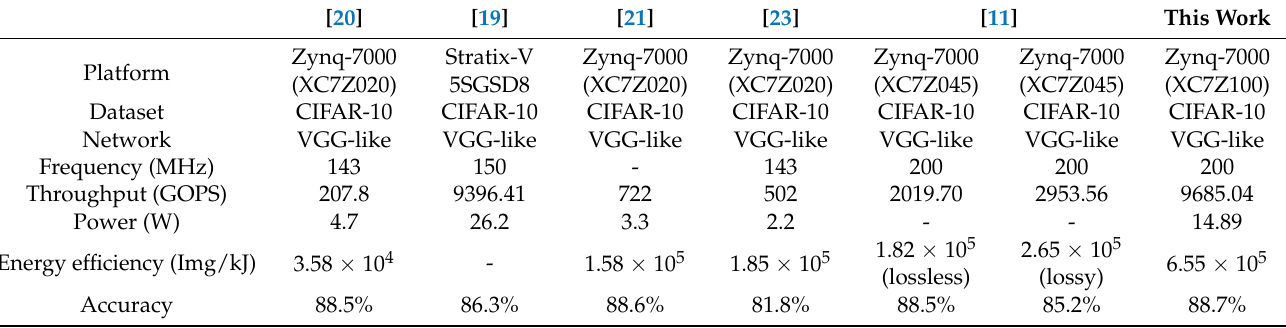
Table 2. Comparisons with other designs on CIFAR-10 dataset.